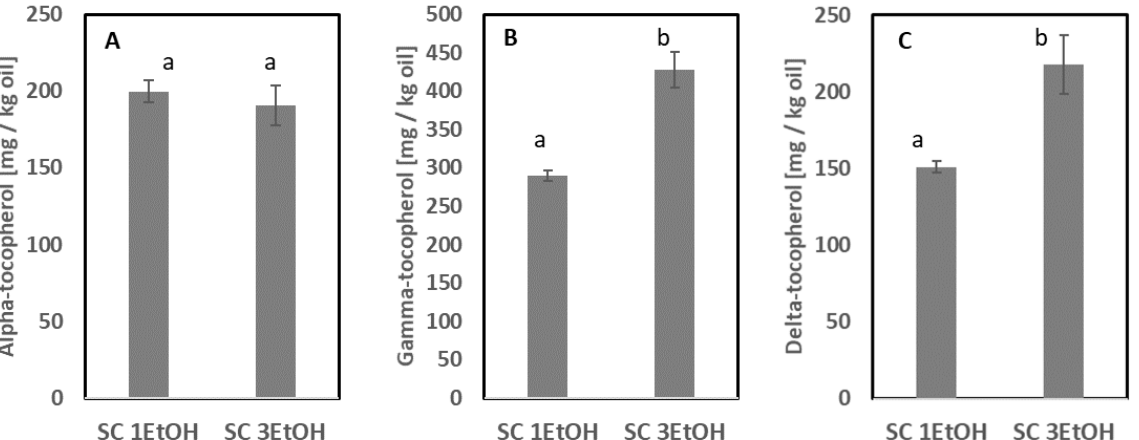
Figure 4. Oil extracted using supercritical CO 2 extraction with EtOH as a co-solvent at different flow rates (1 and 3 mL/min). ( A ) Oil (%), ( B ) phospholipid (%) fraction after direct methylation with toluene, and ( C ) PV (meq. peroxides/kg oil). Sample codes: SC 1EtOH and SC 3EtOH were extracted with 1 and 3 mL EtOH/min, respectively. Error bars indicate the standard deviation of the analytical measurement of 1 sample (n = 2). Different superscript letters indicate significant differences.